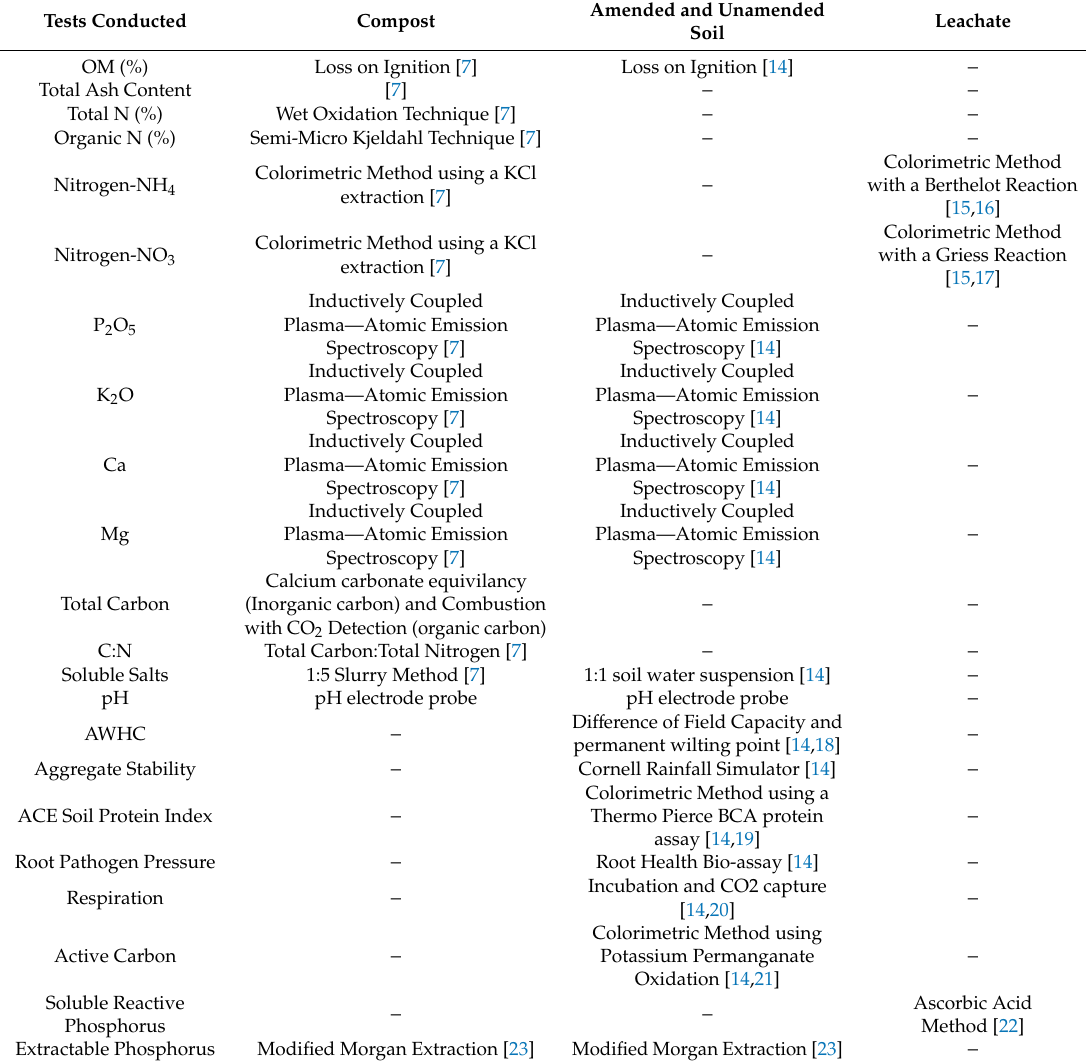
Table 3. Test methods used to test Compost, Amended and Unamended (control) soil and Leachate. Tests conducted on Compost were taken from TMECC protocol manual [7]. Tests conducted on soil were taken from the Comprehensive Assessment of Soil Health: The Cornell Framework